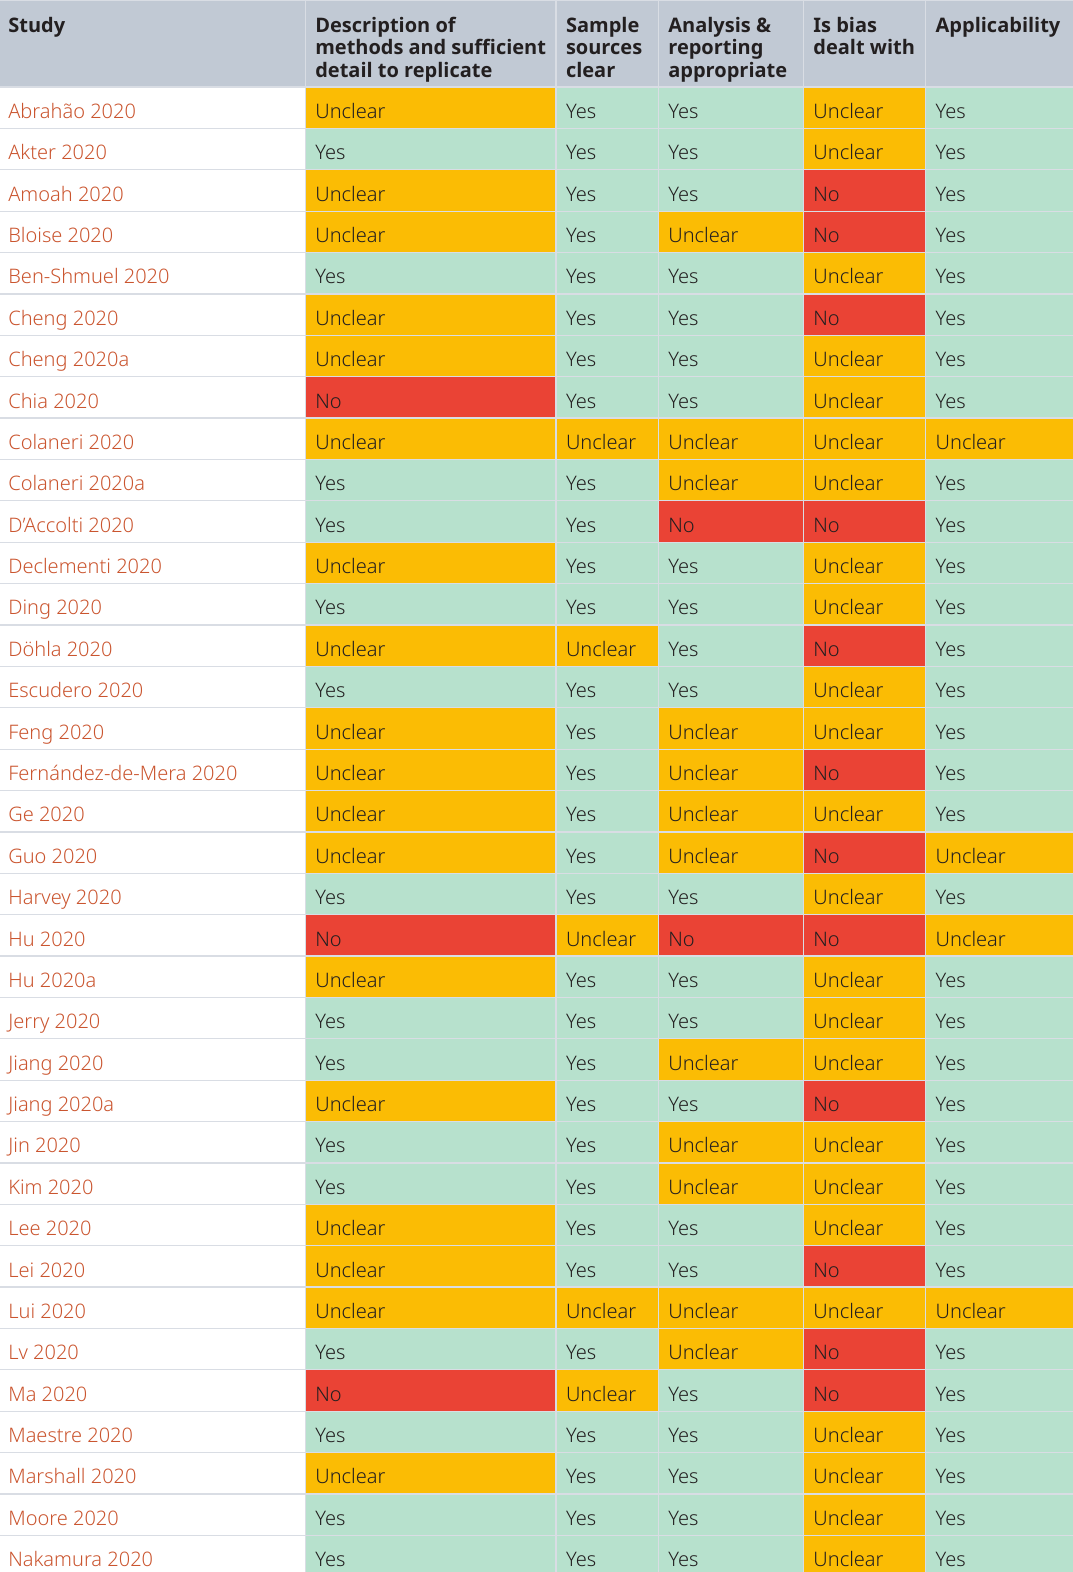
Table 4. Quality of included